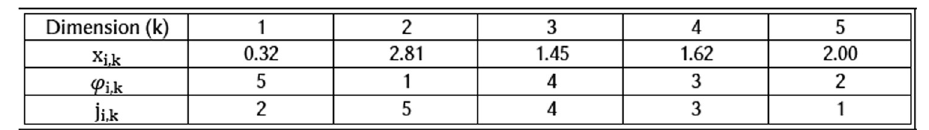
Figure 9: An example of